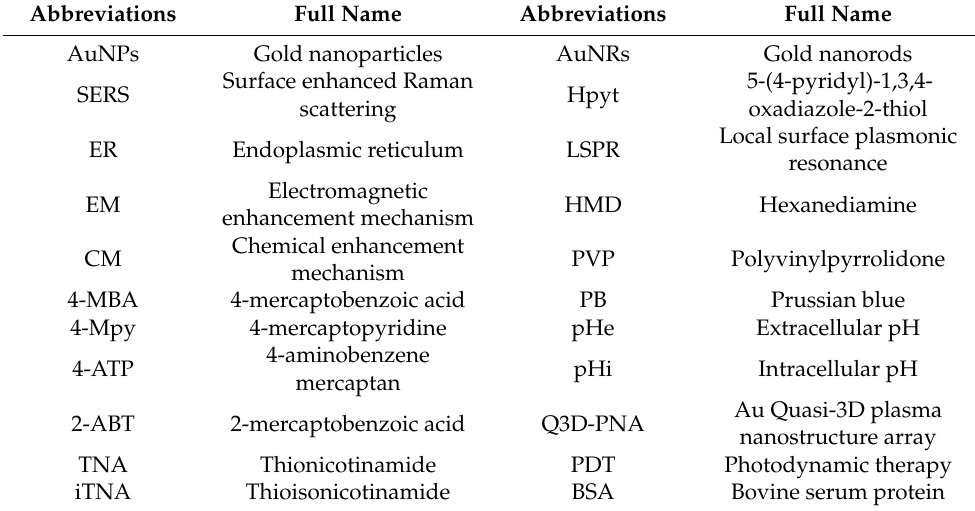
Table 2. Abbreviations used in the